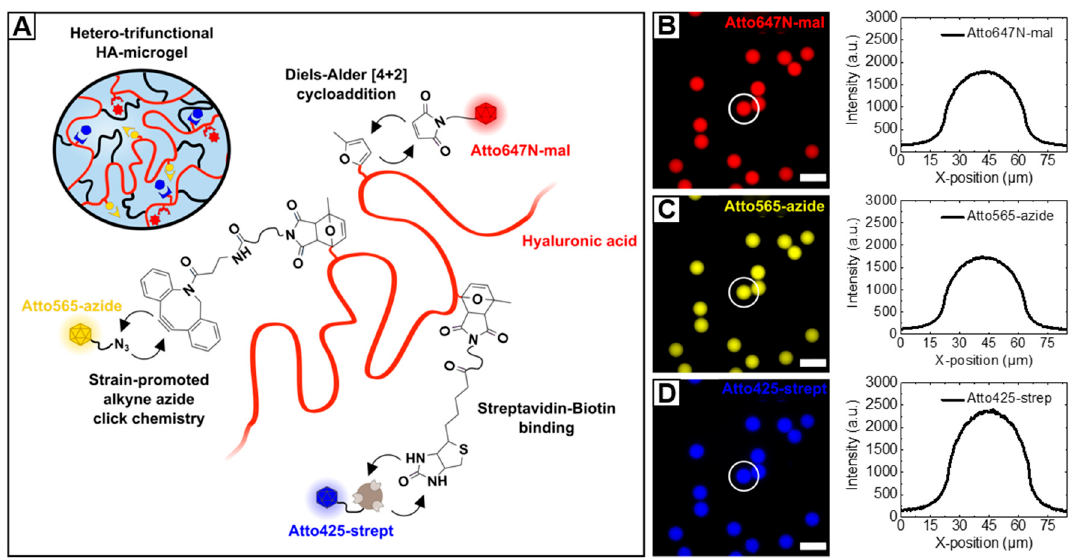
Figure 9. ( A ) Schematic depiction of hetero-trifunctional HA-microgels. By covalently crosslinking methylfuran-moieties with PEG-mal 2 , HA-microgels are formed, whereby remaining methylfurane groups are employed for fluorescent labeling. To proof the availability of biotin- and DBCO-functionalities towards parallel, selective coupling reactions, the HA-microgels are preincubated with Atto425-streptavidin and Atto565-azide dyes via streptavidin-biotin binding and SPAAC, respectively. ( B – D ) Fluorescence microscopy images of hetero-trifunctional HA-microgels (27.6 ± 0.9 µm; n = 100; mean ± SD) incubated with (B) Atto647 N -maleimide, (C) Atto565-azide, and (D) Atto425-streptavidin. Corresponding line scans of individual microgels indicating the homogeneous distribution of the dyes throughout the microgel volume. The scale bars denote 50 µm.